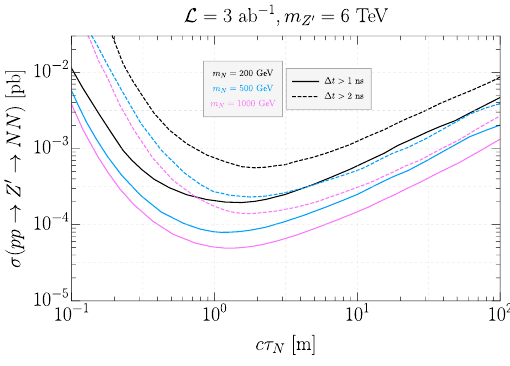
Figure 12 . 95% C.L. exclusion limits on σ N when varying cτ N , for m N = 200 , 500 , and 1000 GeV. with similar kinematics and the same scattering and decay topologies, i.e., a new 6-TeV particle produced from the pp collisions and decaying to a pair of LLPs which subsequently decay into ejj . To better facilitate this purpose, we list the values of Br ( N → ejj ) for m = 200 , 500 , and 1000 GeV: 28 . 6% , 23 . 4% , and 22 . 7% , computed in this N